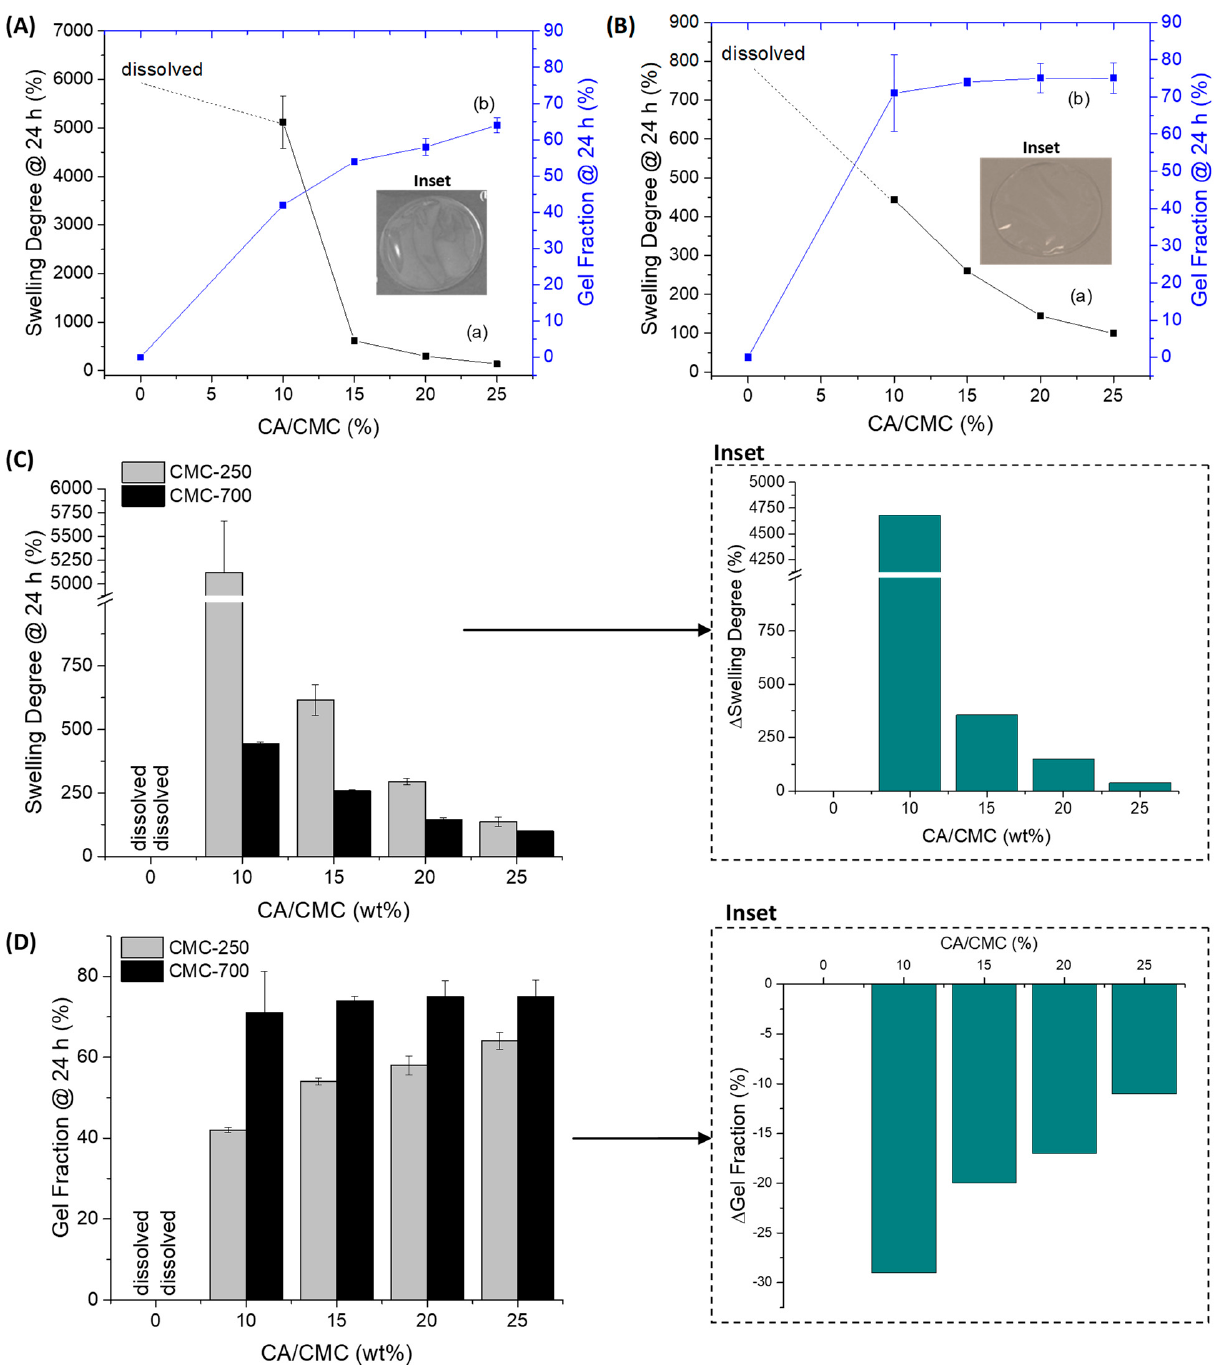
Figure 2. Swelling degree ( a ) and gel fraction ( b ) properties of hydrogels of CMC crosslinked with citric acid: ( A ) CMC-250 and ( B ) CMC-700. Insets: typical hydrogel membranes of CMC-250 and CMC-700 crosslinked with CA. Effect of molecular weight of CMC in ( C ) swelling degree (inset Δ SD) and ( D ) gel fraction properties of hydrogels (inset Δ GF).